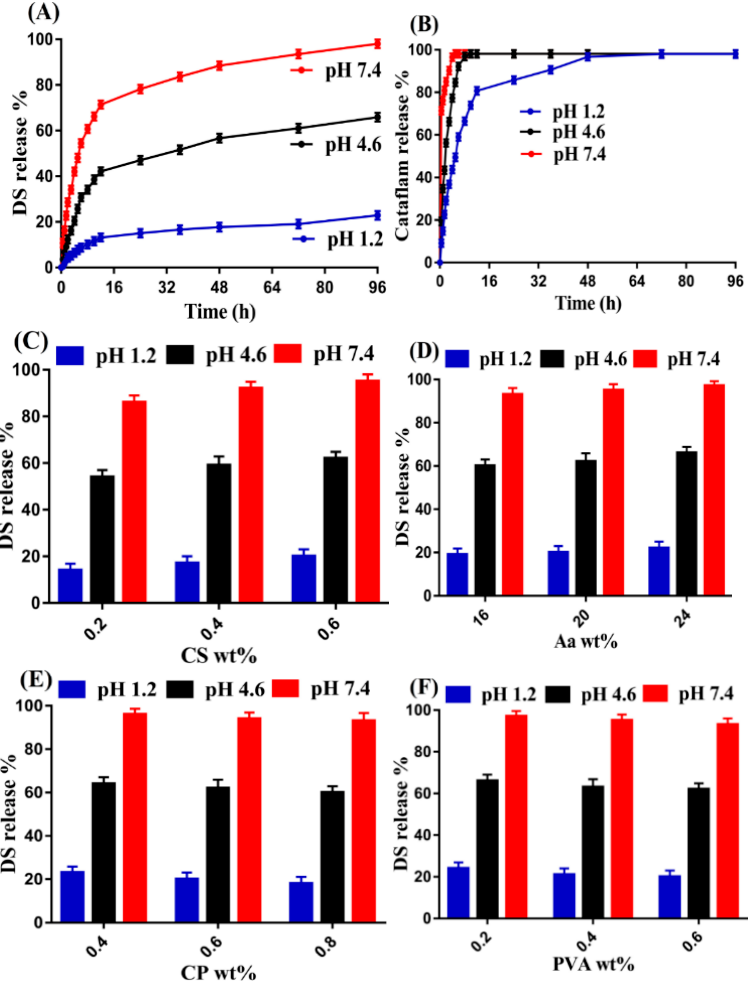
Figure 11. Effect of pH on drug release from ( A ) CS/CP/PVAcPAa hydrogel, ( B ) Cataflam, and effect of ( C ) CS, ( D ) Aa, ( E ) CP, and ( F ) PVA on drug release from CS/CP/PVAcPAa hydrogel.